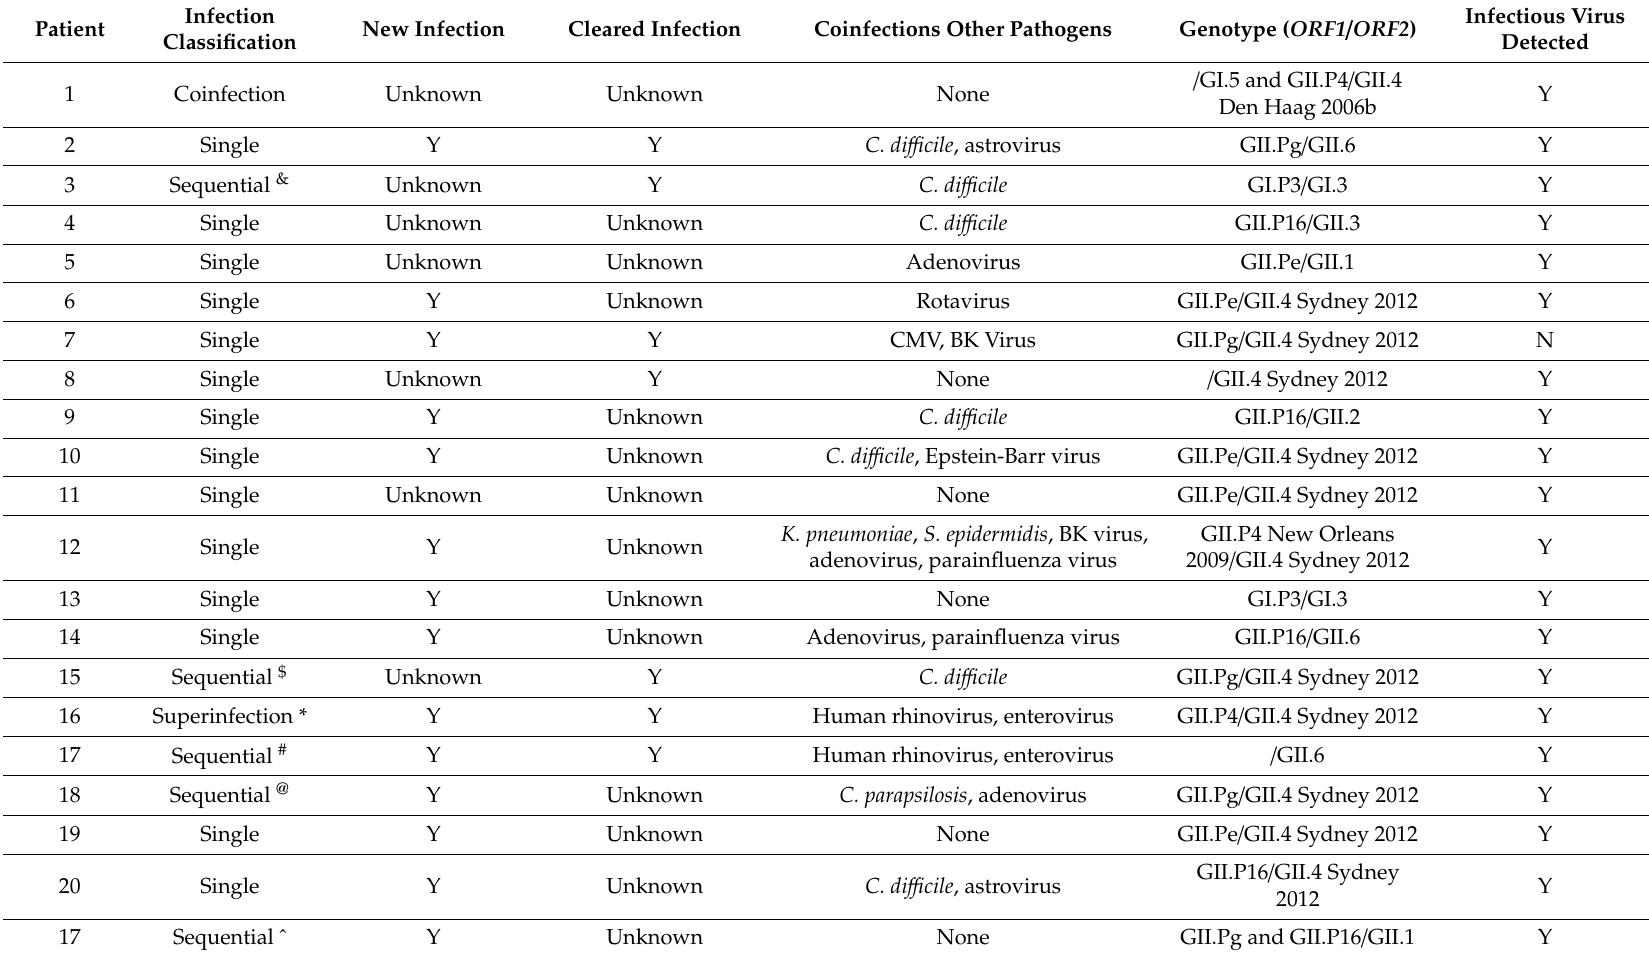
Table 3. Infection characteristics of patients with chronic